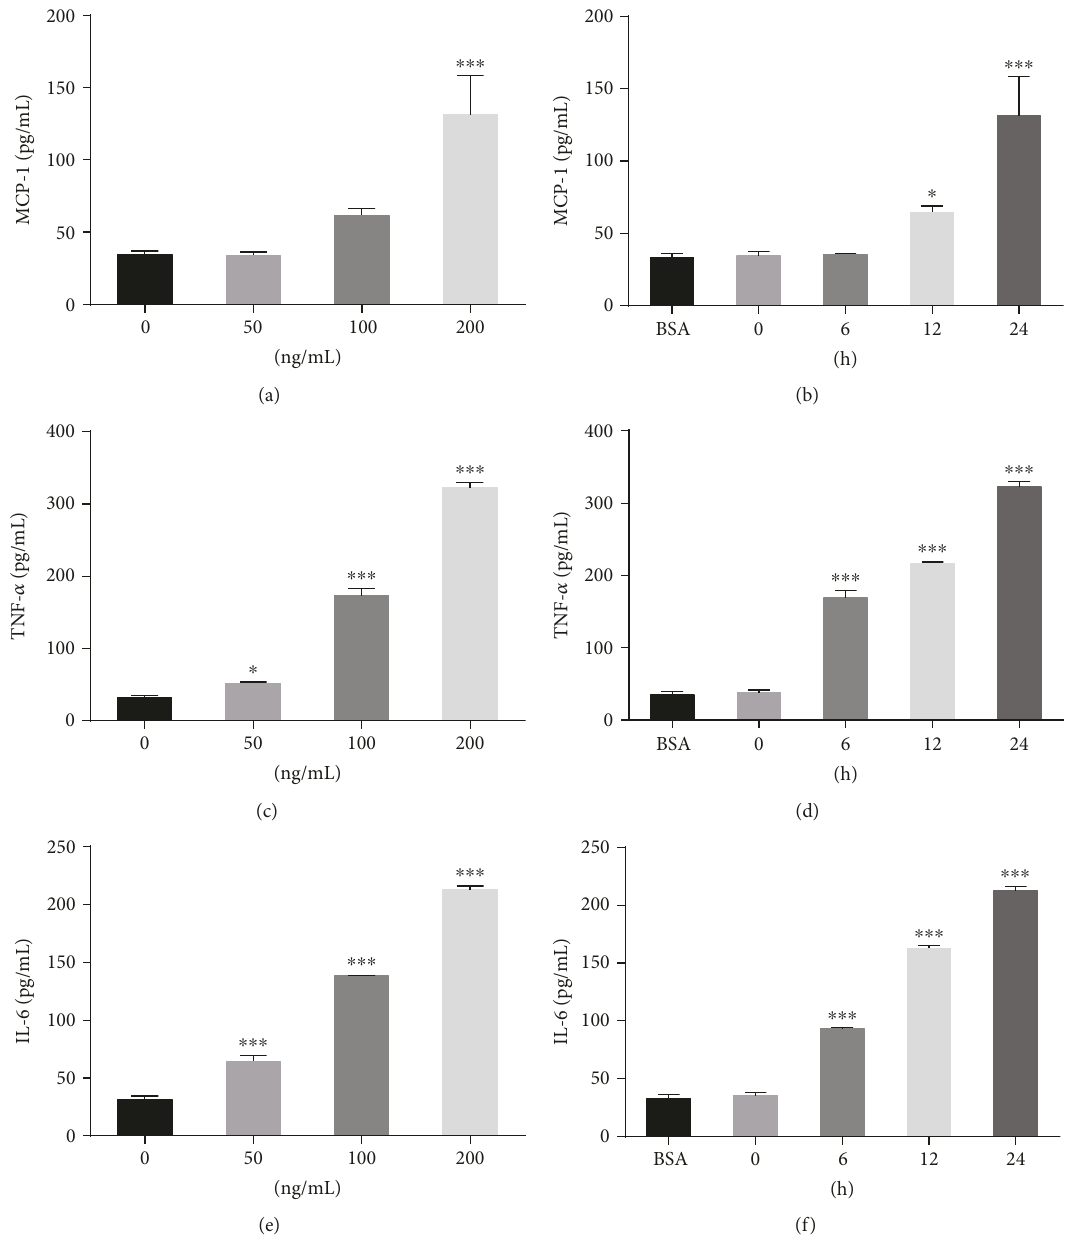
Figure 2: Dose-dependent and time-dependent e ff ects of PAPP-A on MCP-1, TNF- α , and IL-6 productions in the supernatants of RAW264.7 macrophages. (a, c, e) RAW264.7 macrophages were treated with various concentrations of PAPP-A for 24 h, respectively. (b, d, f) Cells were treated with 5 mg/mL BSA for 24 h or with 200 ng/mL PAPP-A for di ff erent durations, respectively. MCP-1, TNF- α , and IL-6 concentrations were measured by ELISA assays. All the results are expressed as mean + SD from three independent experiments, each performed in triplicate. ∗ P < 0 05 vs. baseline and ∗∗∗ P < 0 001 vs.